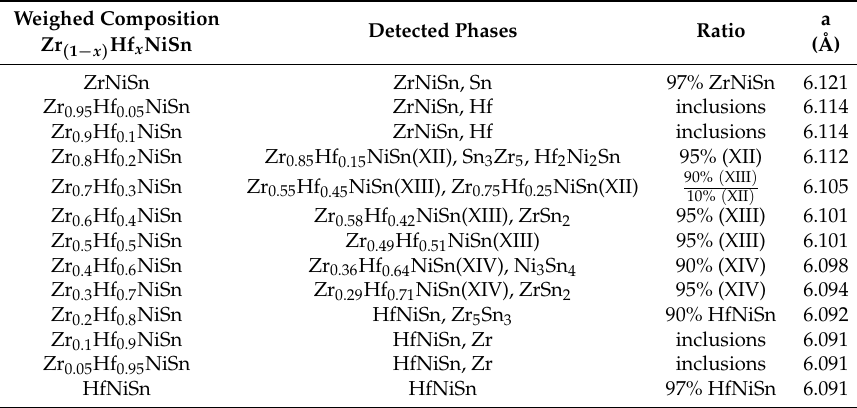
Figure 2. The Zr ( 1 − x ) Hf x NiSn series with the detected phases indicated in the Gibbs triangle. Table 1. The phase compositions of the different Zr ( 1 − x ) Hf x NiSn samples and the parent samples.